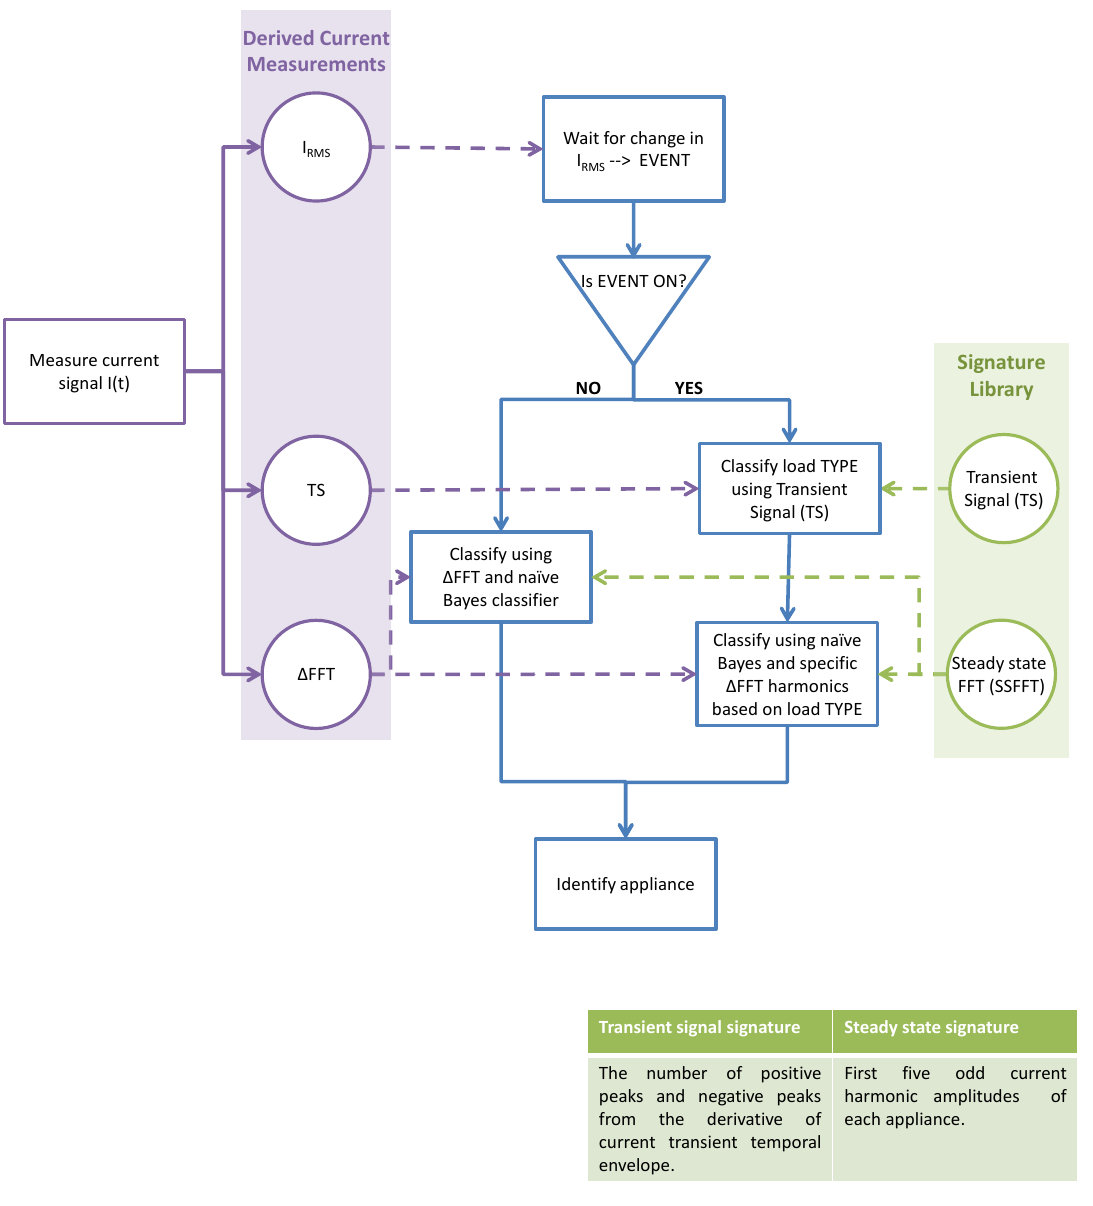
Figure 3. Algorithm flow diagram representing the load identification